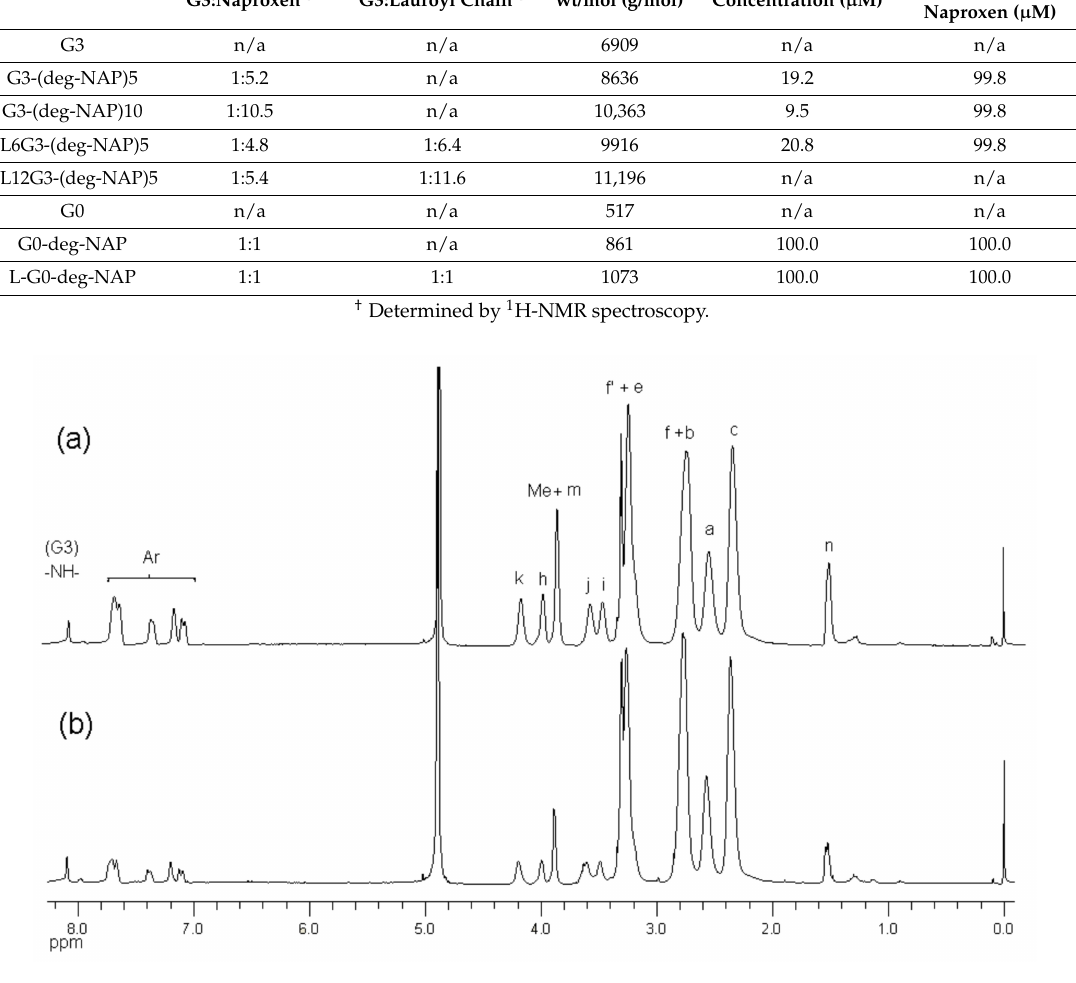
Figure 3. 1 H-NMR ( d 4 -MeOD) spectra of ( a ) G3-(deg-NAP)10 and ( b )